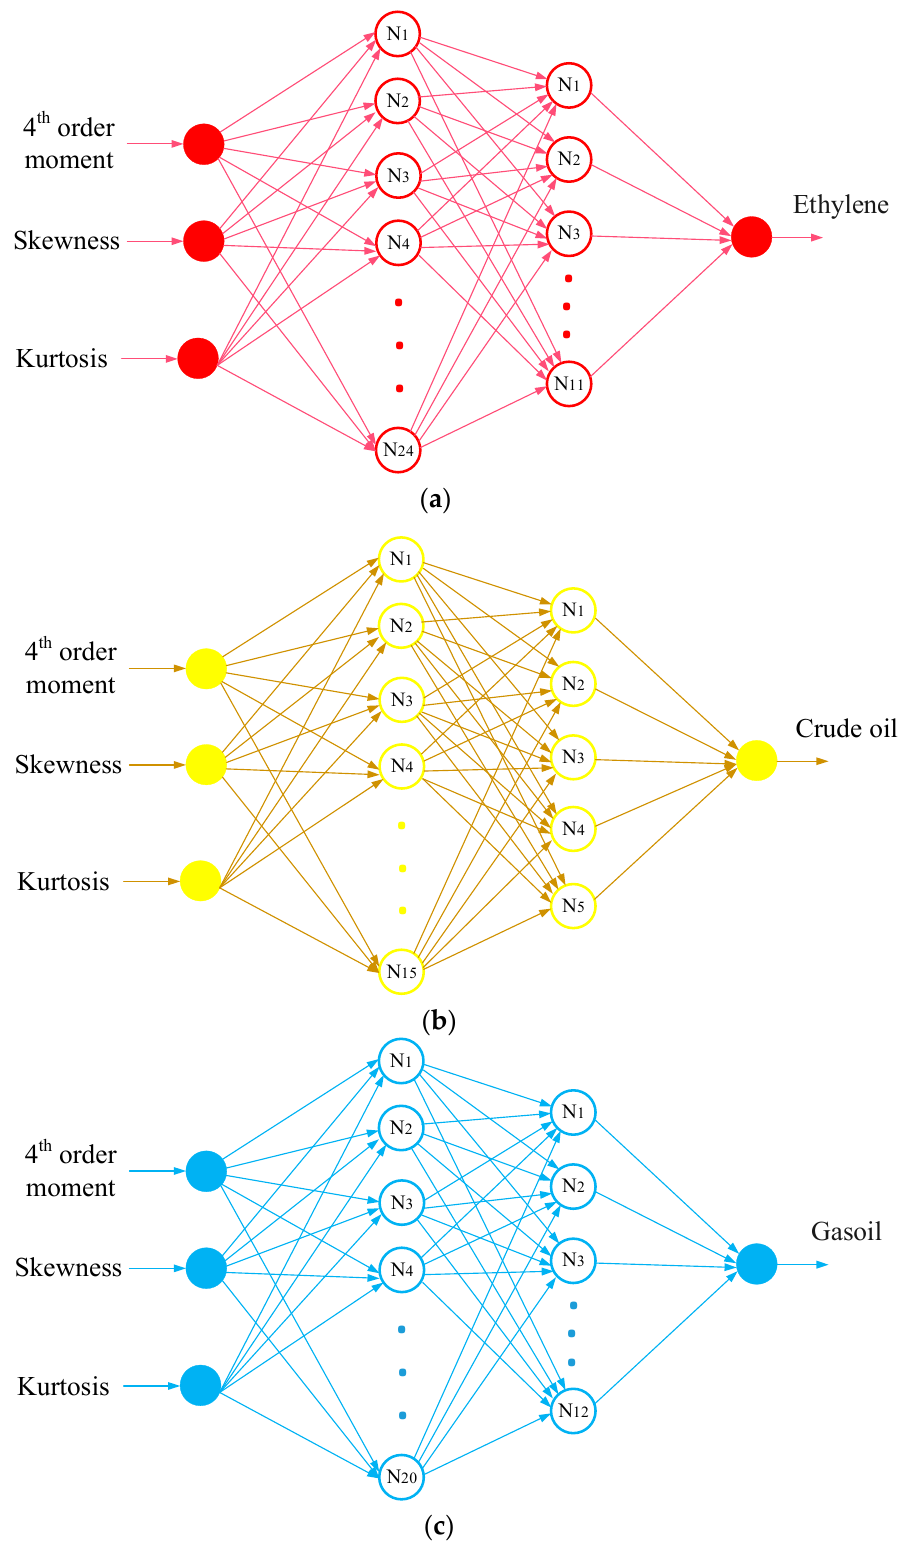
Figure 5. The structure of established MLP neural network for prediction ( a ) ethylene glycol, ( b ) crude oil, and ( c ) gasoil volumetric ratio. Table 1. The characteristics of designed networks.